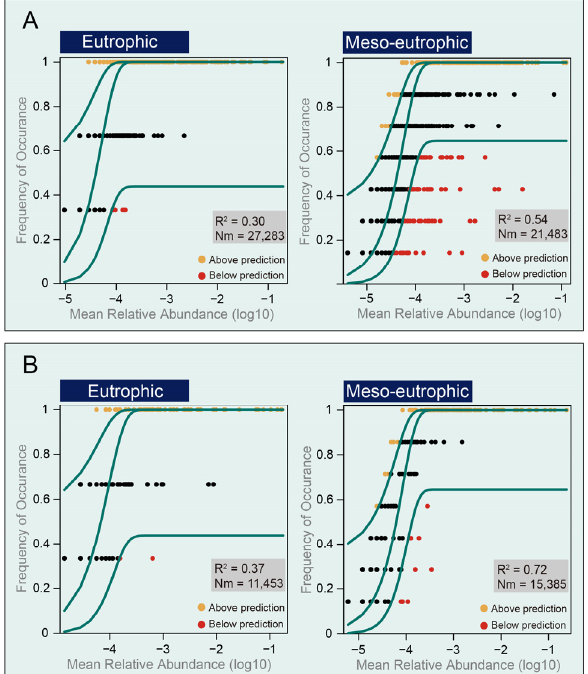
Figure 8. The predicted occurrence frequencies of OTUs from eutrophic and meso-eutrophic regions for prokaryotes ( A ) and eukaryotes ( B ). The solid blue line is the best fit to the neutral community model and the dashed blue line represent 95% confidence intervals around the model prediction. Different colors represent OTUs with more or less frequency than predicted. R 2 indicates the fit to the neutral model and Nm indicates metacommunity size times